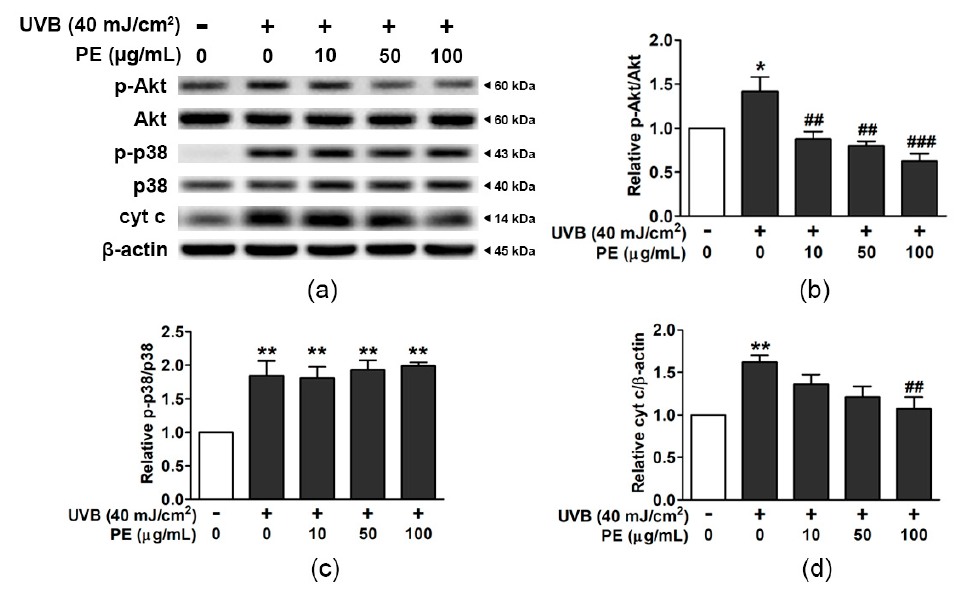
Figure 6. The effects of PE on the UVB-induced activation of p-Akt, p-p38, and cyt c in HaCaT cells. ( a ) The protein bands for p-Akt, Akt, p-p38, p38, cyt c, and β -actin. The relative ratios of ( b ) p-Akt/Akt, ( c ) p-p38/p38, and ( d ) cyt c/ β -actin. The data are shown as the mean ± SEM ( n = 3). *, p < 0.05, and ** p < 0.01, when compared to the non-UVB group; ## , p < 0.01, and ### , p < 0.001, when compared to the UVB-exposed group.